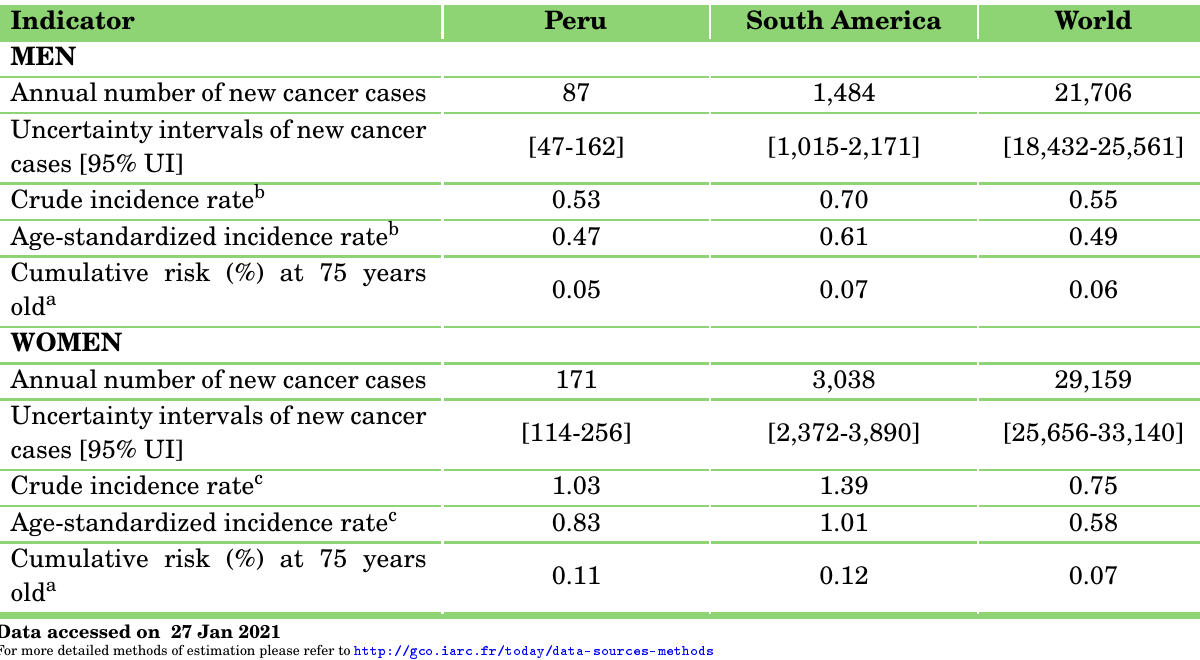
Table 7: Anal cancer incidence in Peru (estimates for